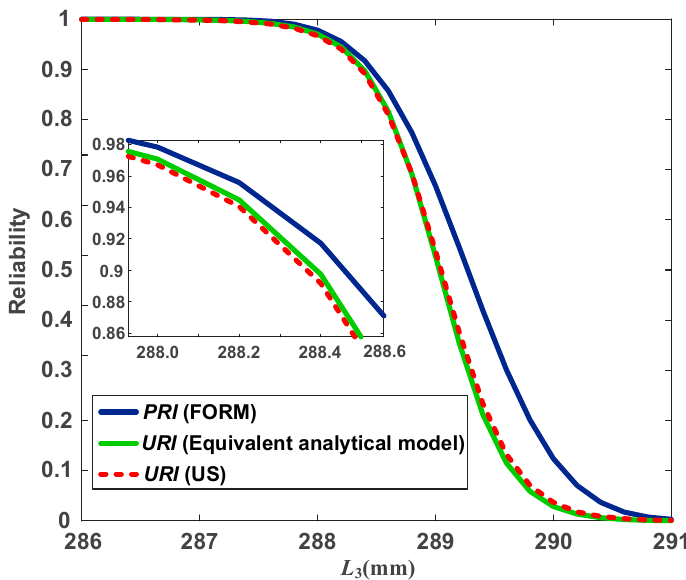
Figure 3. Reliability comparison for the latch lock mechanism.